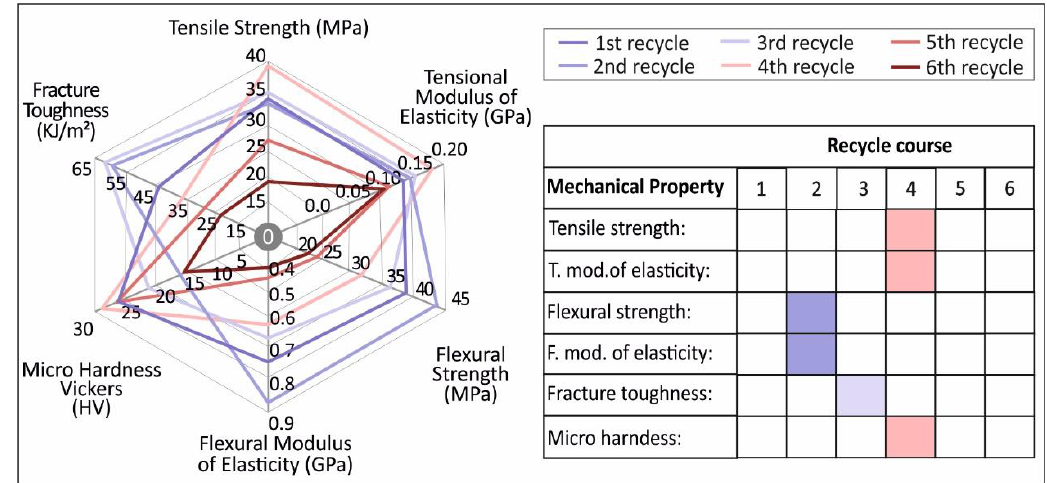
Figure 12. Virgin and recycled in the 6 recycle courses studied in this work PA12 mechanical properties summary.